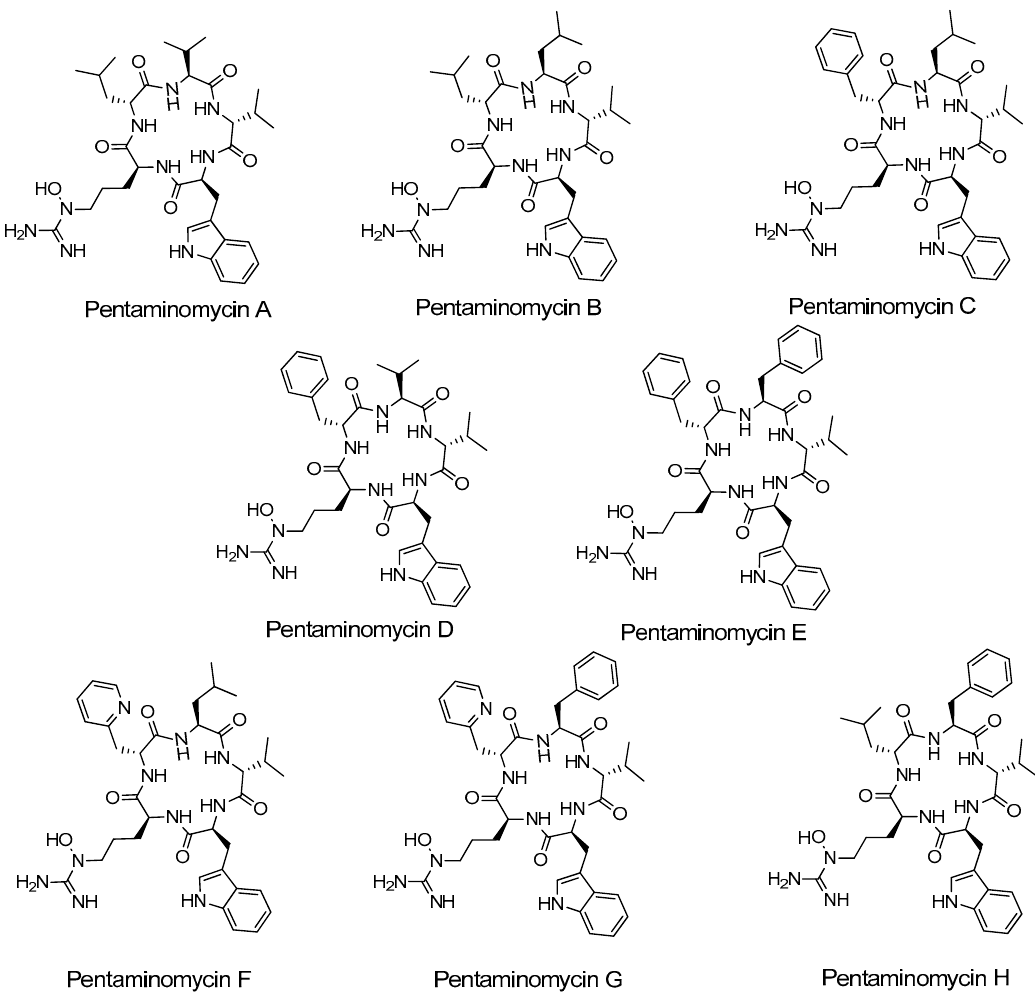
Figure 1. Structures of pentaminomycins A–H.